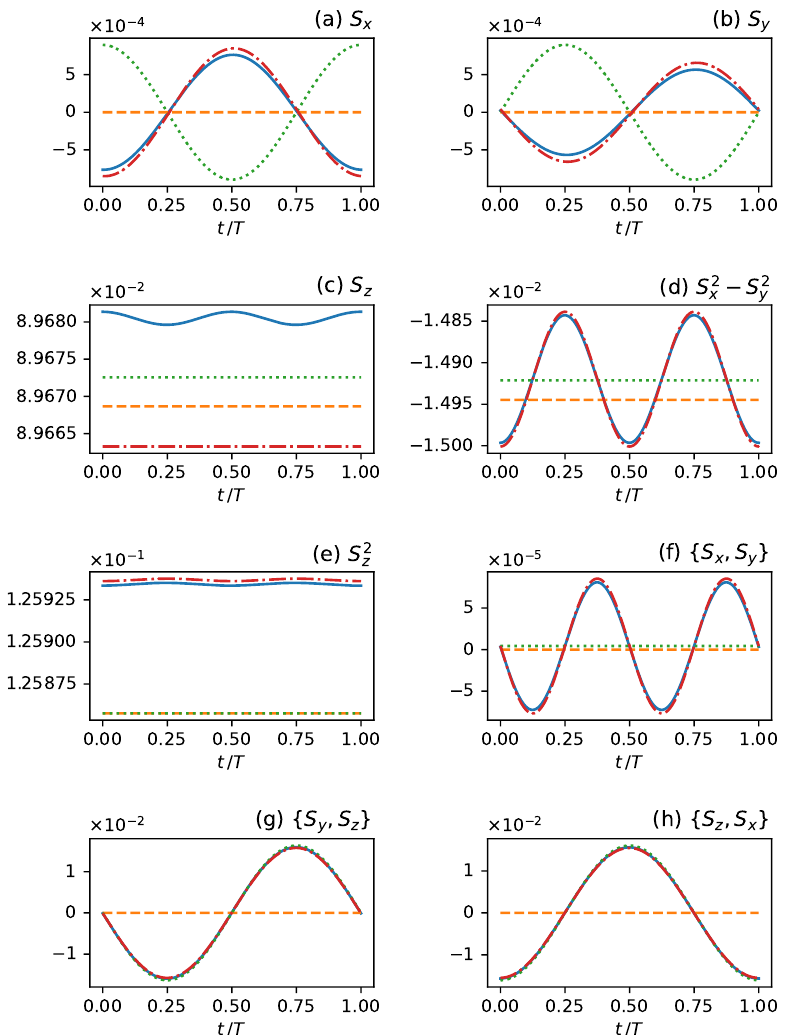
Figure 3: NESS in one cycle calculated by the exact numerical integration (blue) and by the HF expansion approach at order 0 (orange), 1 (green), and 2 (red). All the independent 8 observables are plotted in each panel. The parameters are chosen as = 0.3, N = 1, N = 0.05, B = 0.1, ω = 10, β = 3, γ B s z x y d